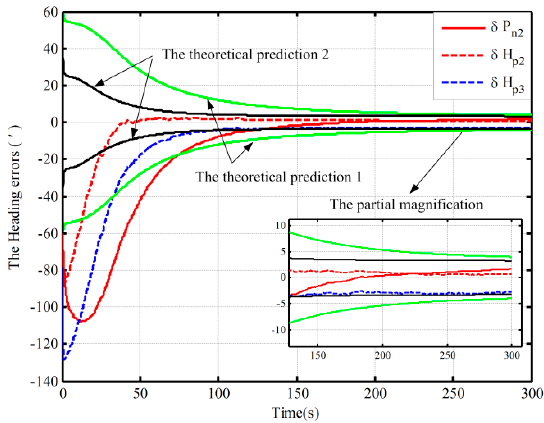
Figure 5. The closed-loop simulations of alignment in Case 1.